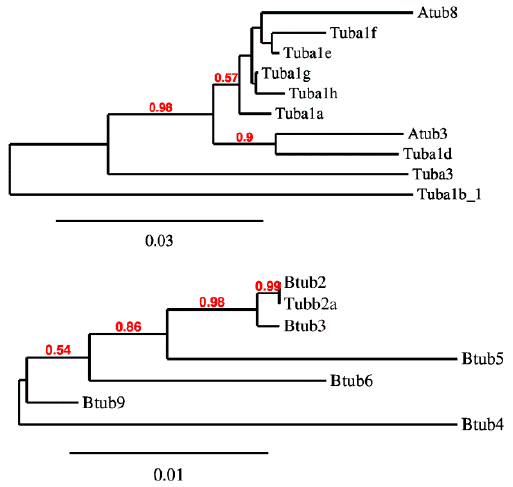
Figure 4. P. lividus α - and β -tubulin NJ distance trees. The trees were generated using MEGA X. The bootstrap consensus tree inferred from 1000 replicates is taken to represent the reliability of the branches of the analysed sequences. The percentage of replicate trees in which the associated taxa clustered together in the bootstrap test (1000 replicates) greater than 50% are shown in red next to the branches.